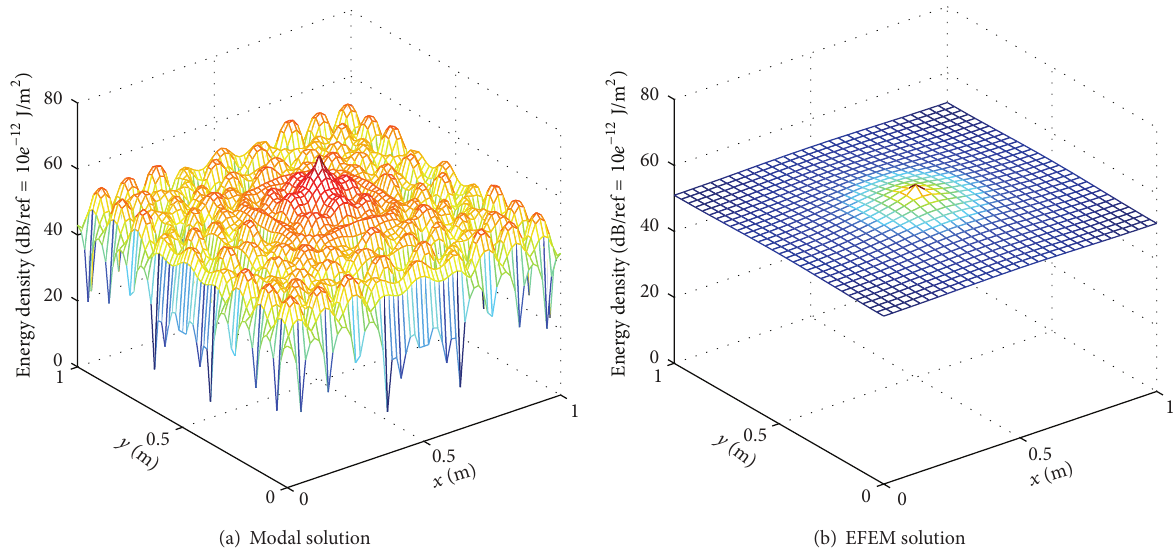
Figure 5: The energy density distributions of the plate in case 2 calculated by both modal superposition method and EFEM.